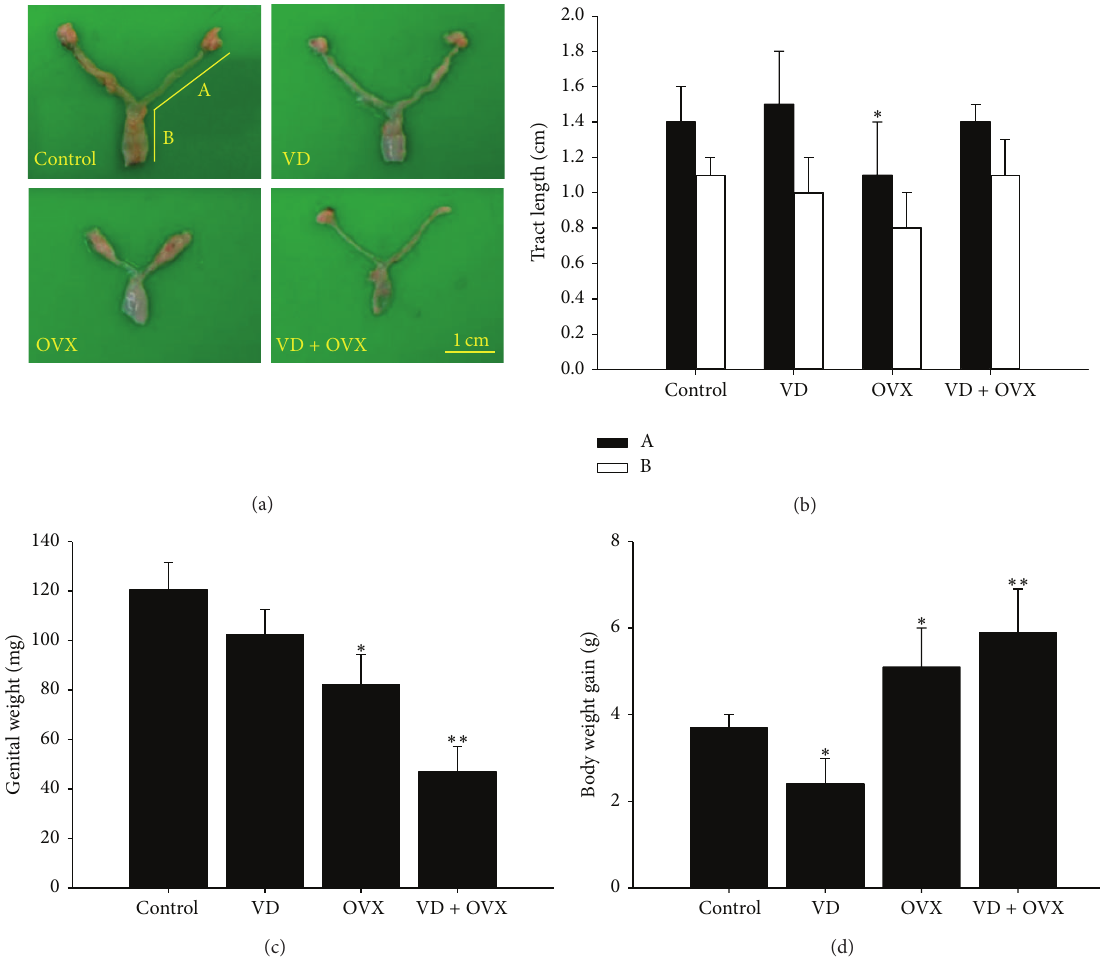
Figure 1: (a) Morphology of the genital tract in the different groups (A and B reflect genital tract lengths in (b)). The four groups differed significantly in (b) genital tract length, (c) genital weight, and (d) body weight gain. Data are expressed as mean ± SEM; ∗ 𝑃 < 0.05 compared with control. ∗∗ 𝑃 < 0.01 compared with